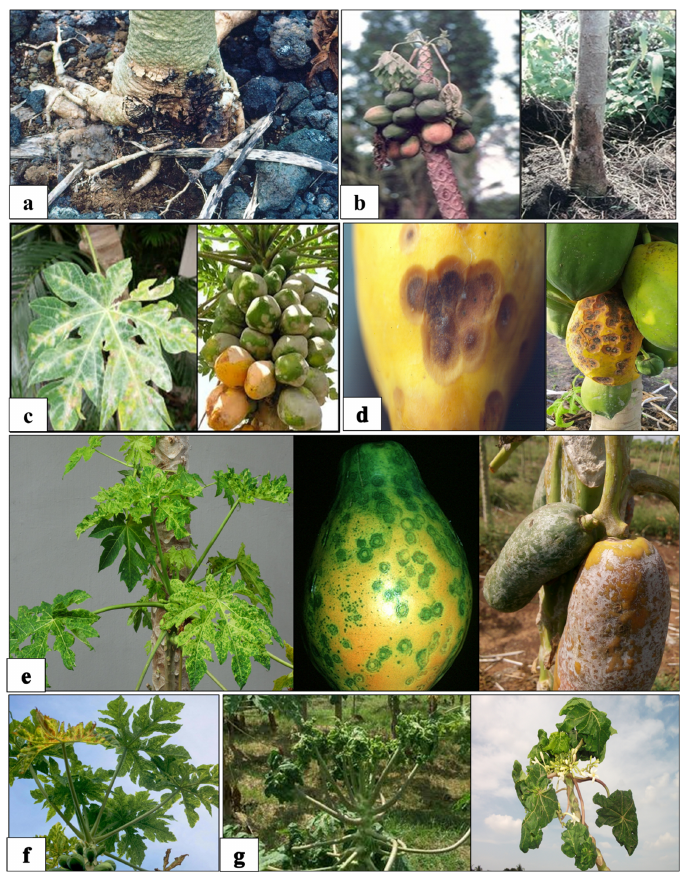
Figure 3. Fungal and viral disease in papaya. ( a ) Stem rot in papaya due to Pythium aphanidermatum. ( b ) Infected stem and malformed apical portion caused by Phytophthora palmivora. ( c ) Infection in leaves and fruits caused by Oidium caricae . ( d ) Fruits affected by fungus Colletotrichum gloeosporioides. ( e ) Ring-shaped spots on leaves and fruits due to PRSV. ( f ) Leaves affected by PMV and ( g ) curly leaves symptoms due to PLCV. 7.1. Foot Rot/Stem Rot (Fungi: Pythium Aphanidermatum) Soil-borne fungal pathogens of the oomycetes class are usually found in waterlogged and humid conditions. Water-soaked lesions form at the base of the stem, decaying the tissue and transforming it into a black necrotic area [70]. Because of an insufficient water